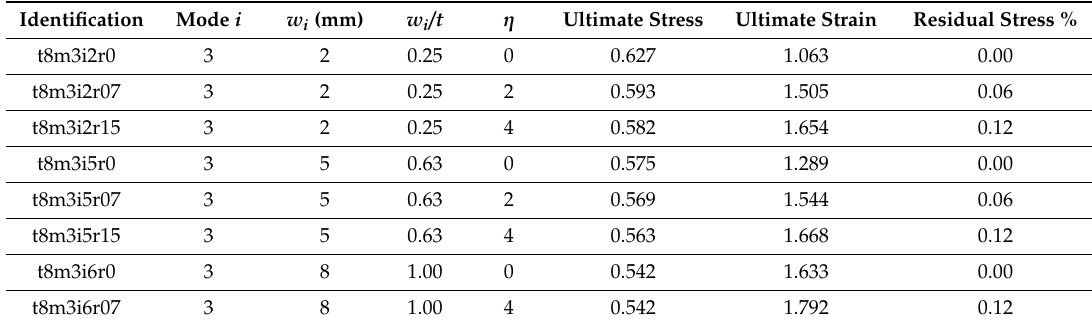
Table 4. Summary of data and main results for plates with a = 1.5 m, b = 0.6 m and t = 8 mm.